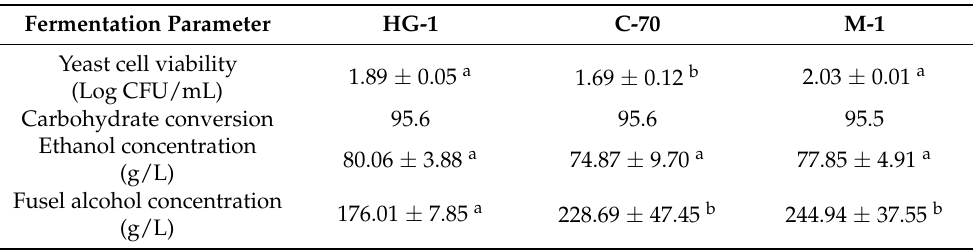
Table 1. Fermentation results by using different yeast strains. Fermentation conditions: T = 30 ◦ C, 200 rpm, pH = 5.5, time = 24